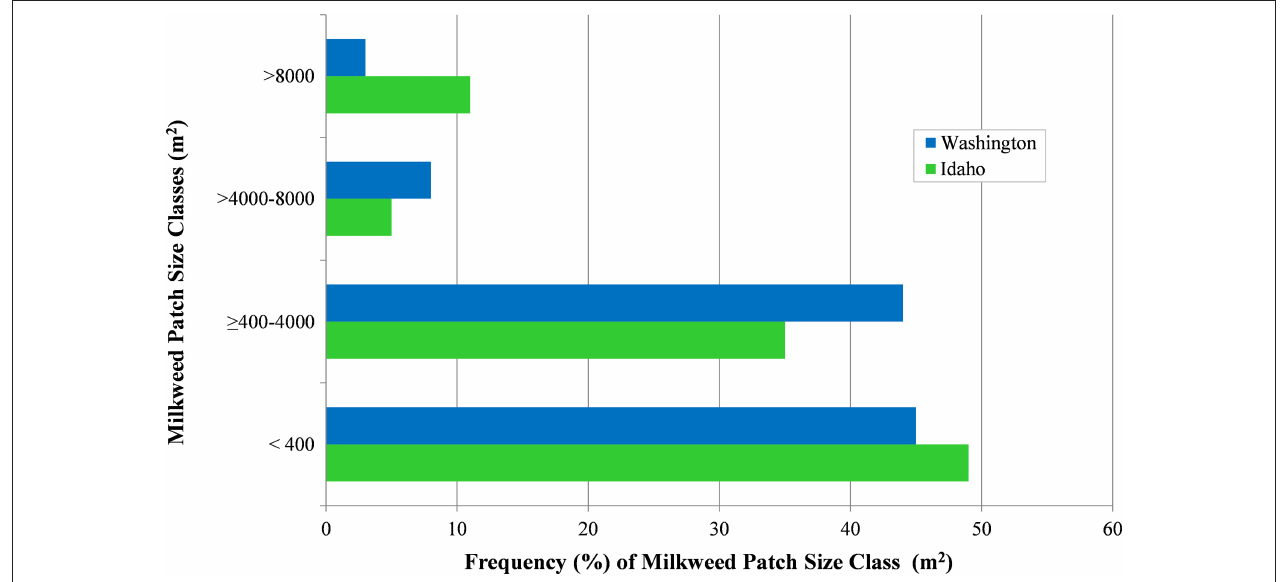
FIGURE 8 | Patch size (m 2 ) frequency (%) among milkweed patches ( n = 1,232), Idaho and Washington,